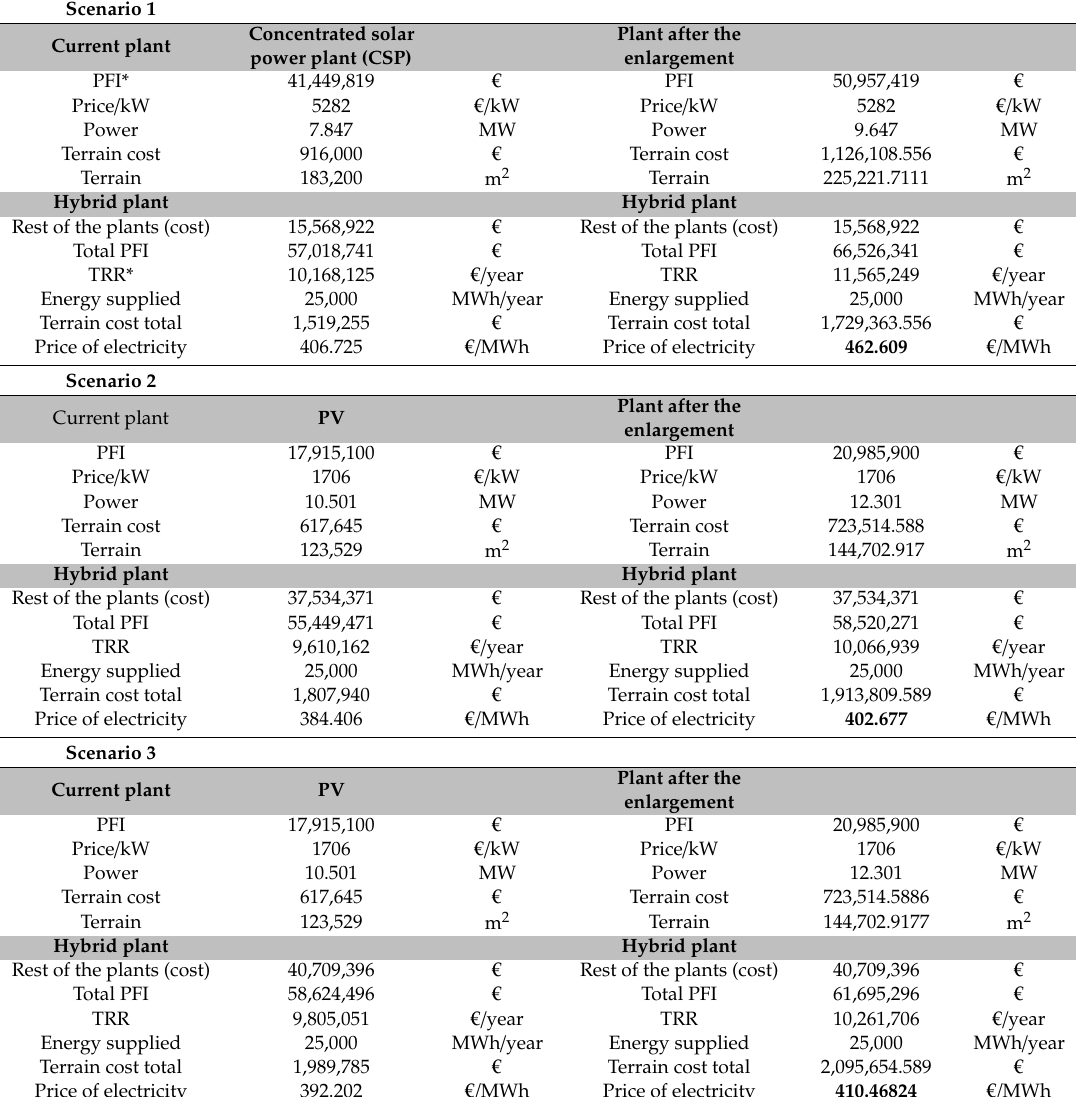
Table A1. Results of economic analyses.